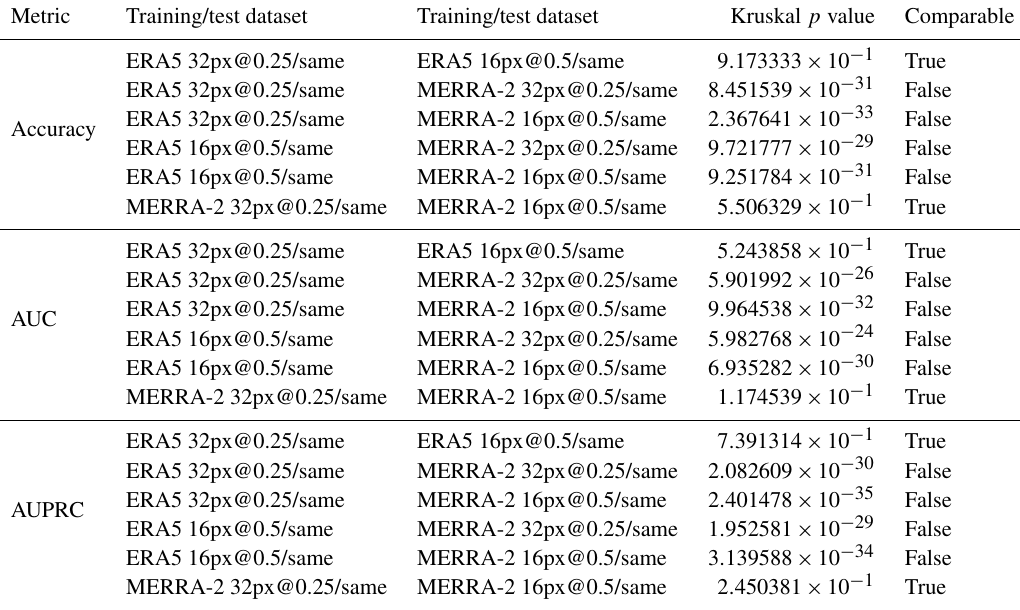
Table A3. Comparisons of metric values of models taken two by two (intercomparisons). The column “Kruskal p value” refers to the p value of the Kruskal–Wallis test computed on all the values of the metrics. The column “Comparable” indicates whether the null hypothesis is accepted for an alpha level of 1%.